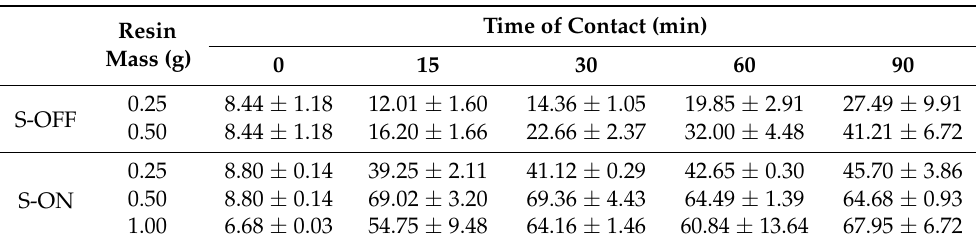
Table 3. Purification ratios (%) obtained for Dowex 50W-X8 resin 50–100 mesh (results correspond to the average of three replicates ± standard